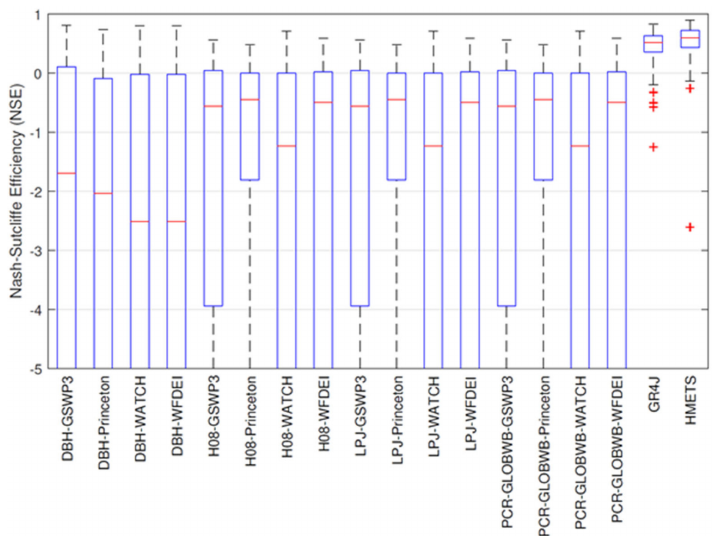
Figure 4. NSE scores of the 16 gHM–climate–dataset combinations and rHMs used in this study. The red line in the box plots represents the median value; the ends of the boxes represent the 25th (lower) and 75th (upper) quantiles; outliers are shown as red crosses (+). Figure 5 confirms that all gHMs perform unsatisfactorily, with systematic large positive biases for all global driving datasets (PBIAS > +25%). DBH displays an overall poor performance, whatever the global meteorological dataset used to drive the gHM. Regarding the other three gHM–climate–dataset combinations, we can see those biases in terms of median values and 25th–75th quantile boxes are lower. These three gHM–climate–dataset combinations show comparable findings in terms of relative bias for the discharge values at the catchment scale and similar inter-gHM variability, as expressed by the box plots. Besides DBH, it seems that the choice of the global meteorological dataset used to drive the gHM has a greater influence on the variability of the results than does the choice of gHM. The gHM–Princeton combinations give the lowest variability in simulated discharge values in terms of relative bias.